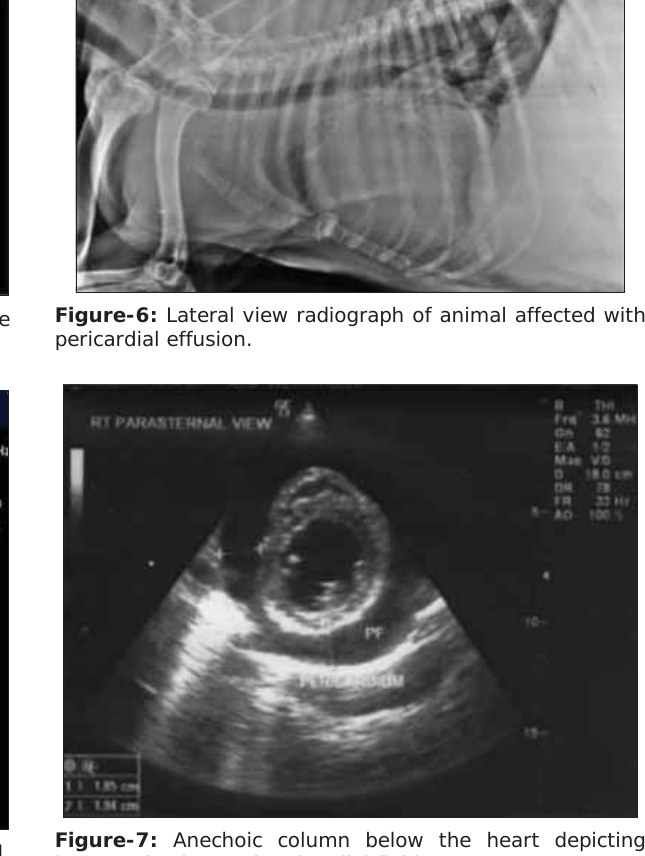
Figure-4: Increased EPSS of the animal affected with DCM.